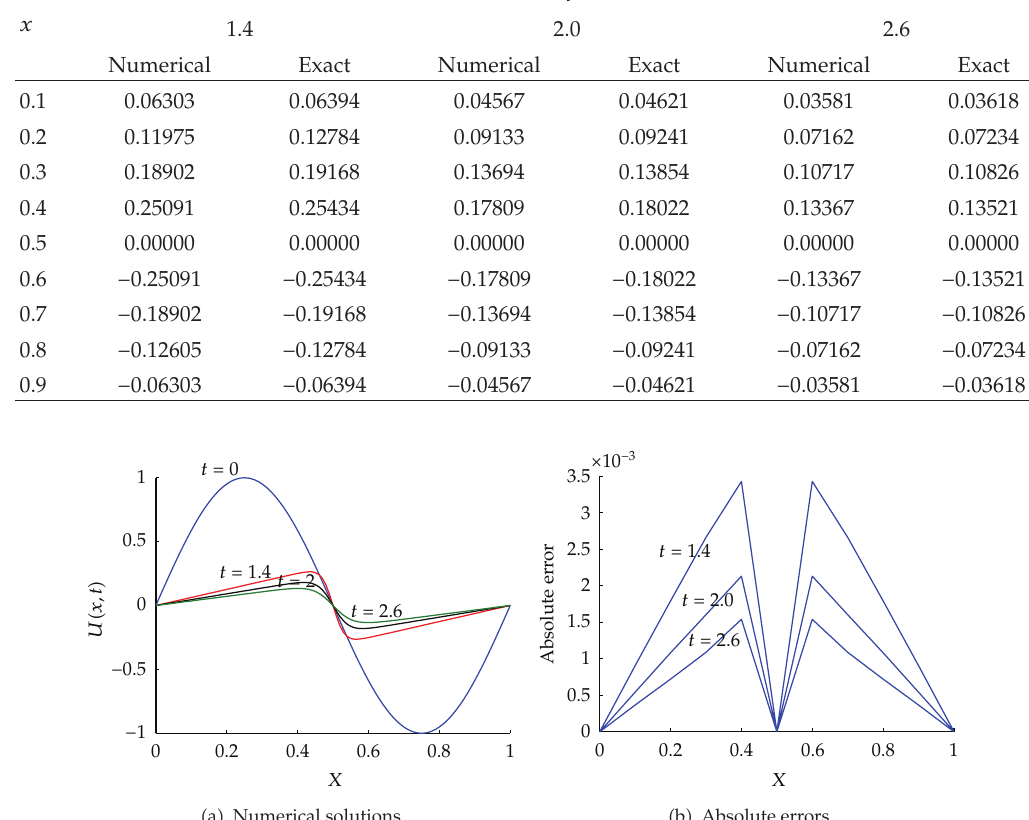
Table 3: Comparison of the LB finite di ff erence solutions with exact solution for ν (cid:8) 0 . 005 with dx (cid:8)